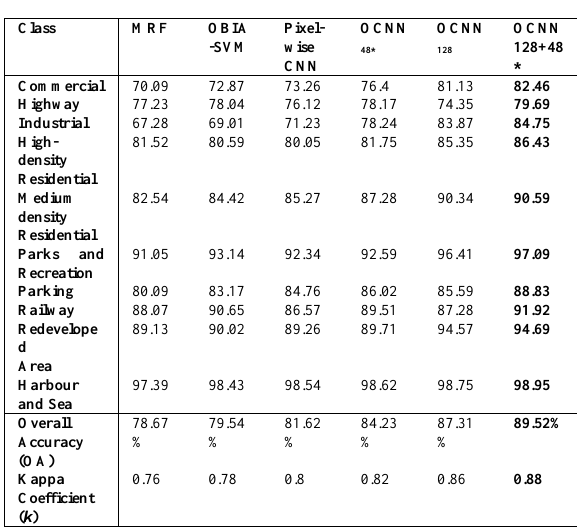
Table 1. Classification accuracy comparison between MRF, OBIA-SVM, Pixel-wise CNN, OCNN48*, OCNN128, and OCNN128+48*. Overall accuracy (OA) and Kappa coefficient ( k ). ‘Bold’ highlights the highest accuracy per method